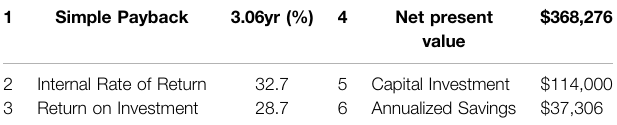
TABLE 7 | Investment cost of proposed